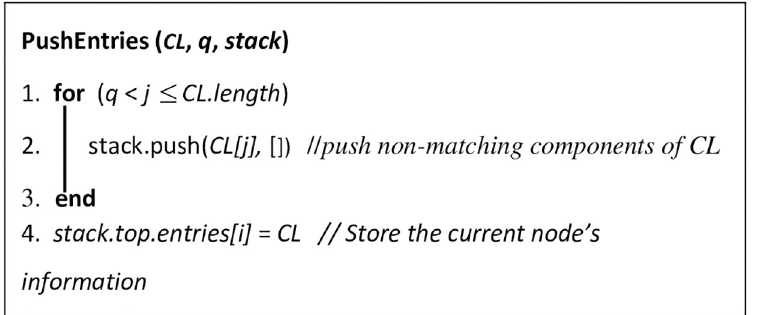
Fig 15. Subroutine PushEntries.